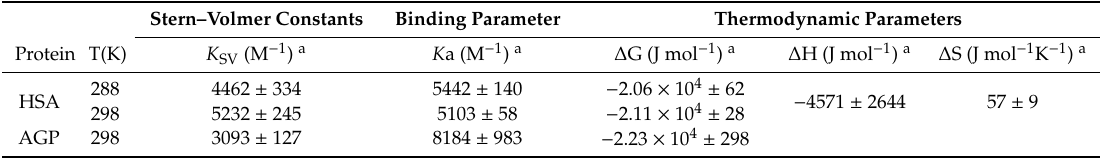
Table 2. Stern–Volmer constants ( K SV ), binding parameters ( K a) and thermodynamic